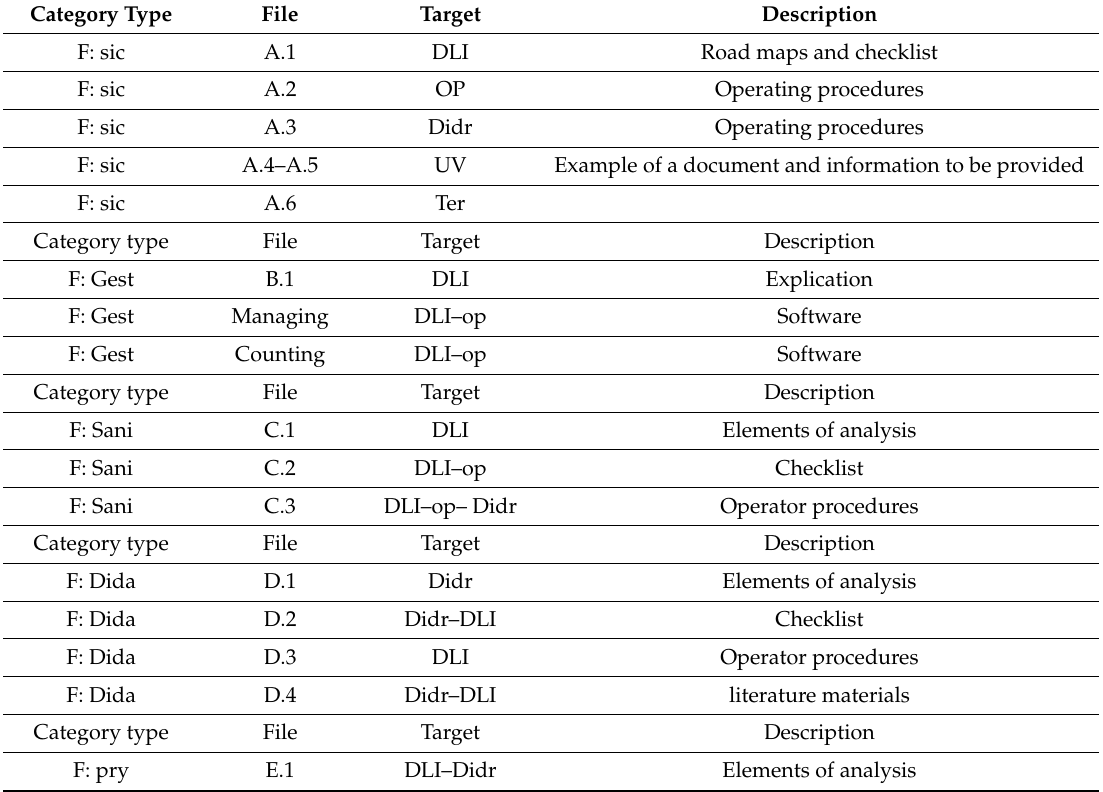
Table 4. Classification of the research as a function of the methods used and the reading of the results. Category Type